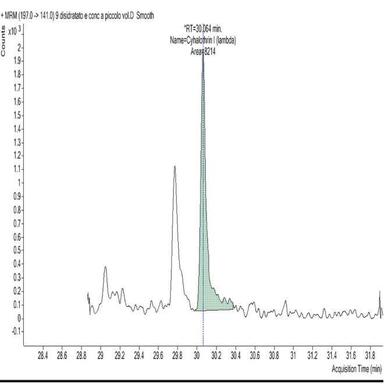
CS formulation: λ-Cyalothrin by GC-MS/MS in pristine form a) and 1st fraction eluted by AF4-FFF-MALS b).